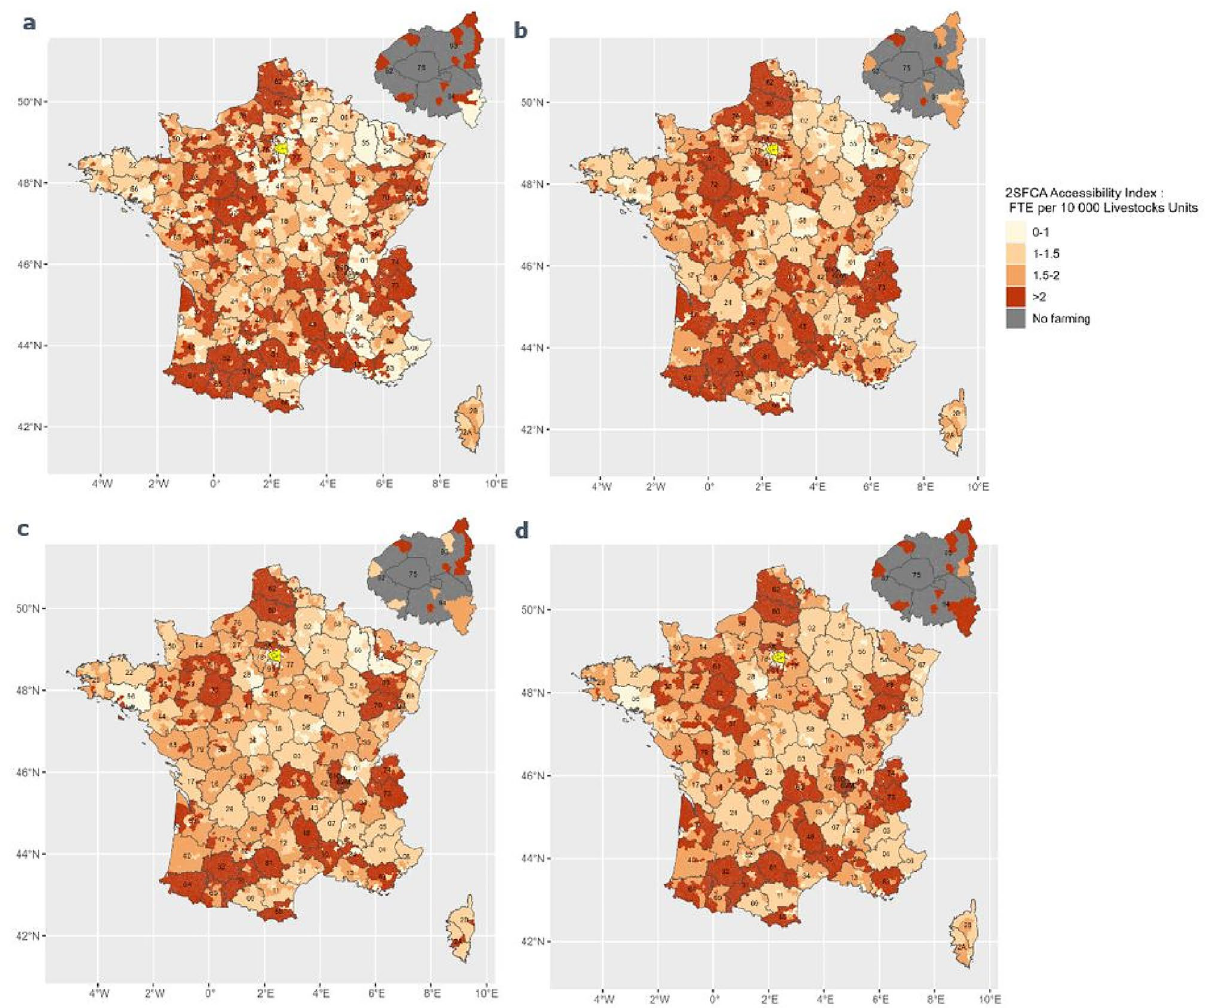
Figure 1. Spatial accessibility of the cattle sector to veterinarians in France for various travel time thresholds.